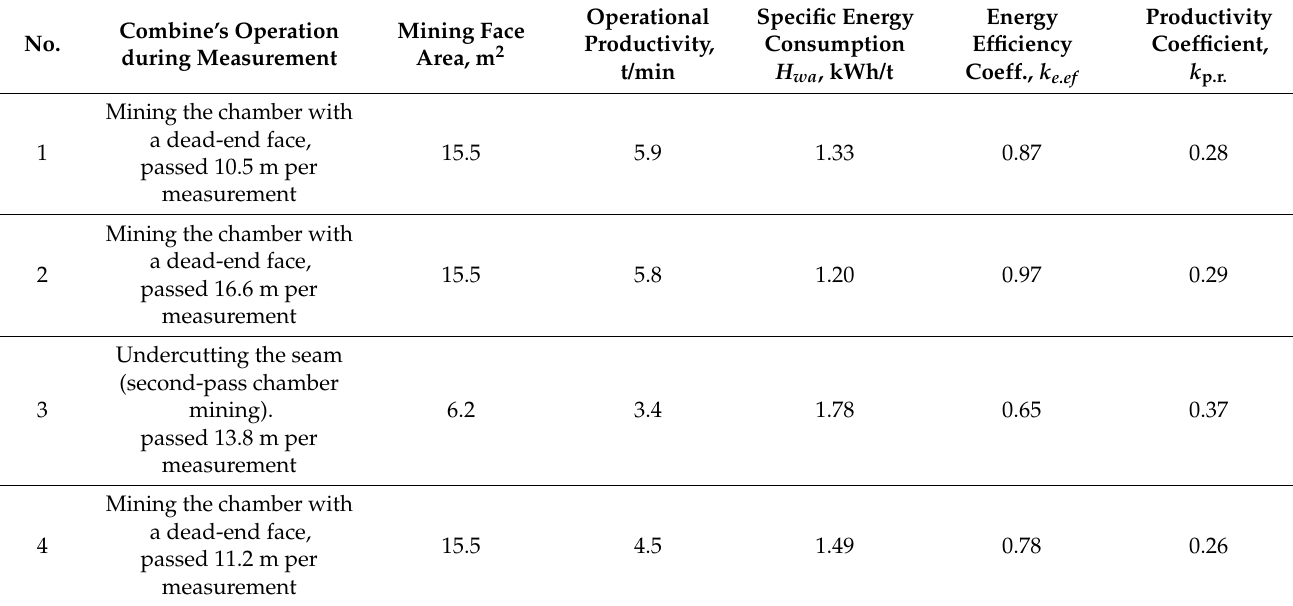
Table 2. Values of energy efficiency coefficients, breakdown by combine operation in various mining